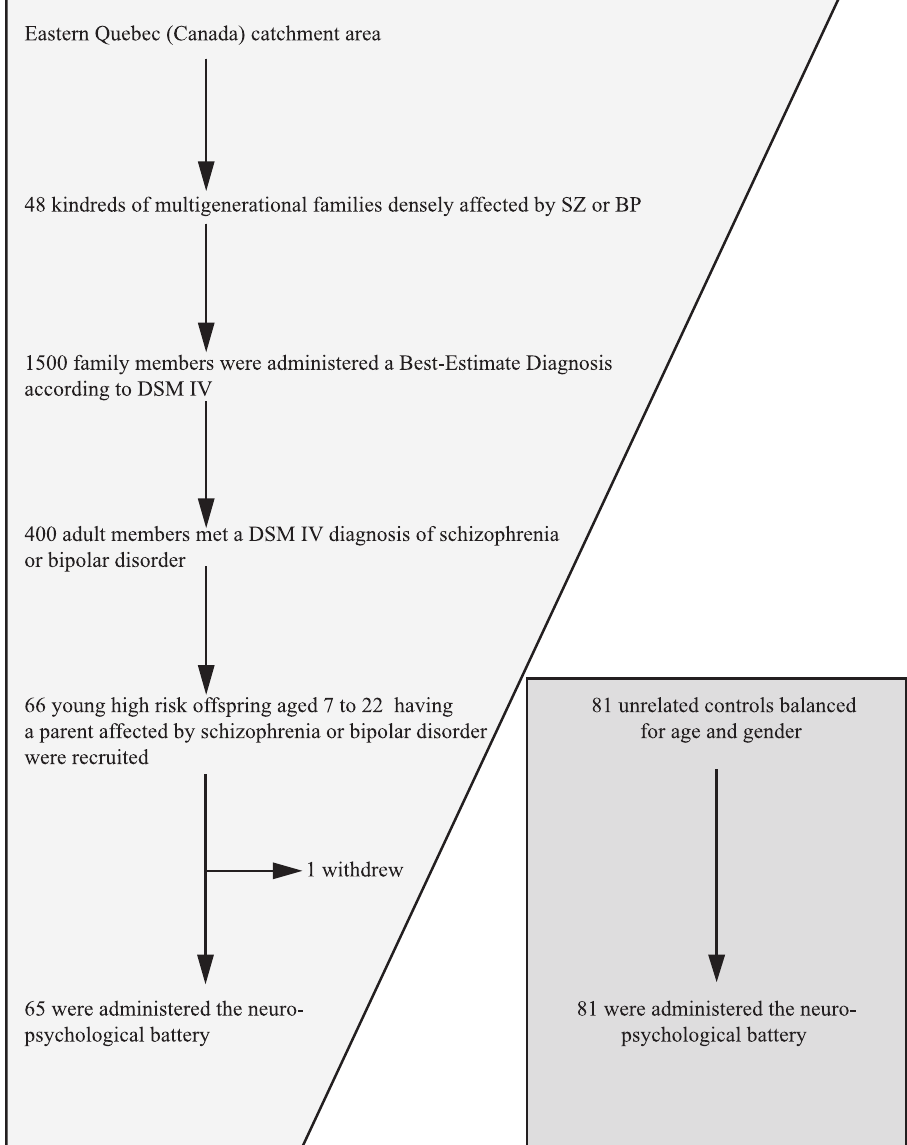
Figure 1. Flowchart of participants in a stepwise sampling approach to narrow-down the early disease mechanisms in this high-risk sample. In a high risk sample, we used a step by step sampling approach to narrow-down the early disease mechanisms. Upstream, we started with a 20-year follow-up of 48 densely affected multigenerational kindreds, including 1500 clinically characterized adult members who were all administered a consensus best-estimate lifetime diagnosis. From these, we then identified 400 members affected by a DSM-IV schizophrenia or bipolar disorder. Downstream, we finally focused on 65 offspring aged 7 to 22 having an affected parent, and the 65 were administered the neuropsychological